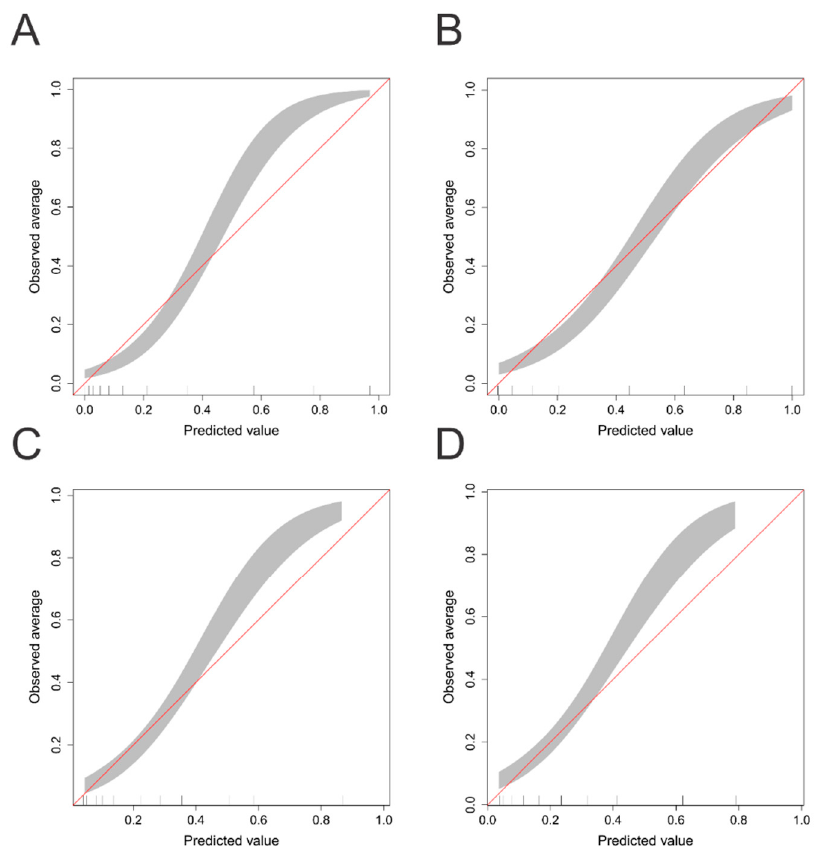
Figure 3. Calibration belts of ( A ) random forest, ( B ) bagged classification and regression tree (bagged CART), ( C ) NTISS, and ( D ) SNAPPE-II for NICU mortality prediction in the test set.